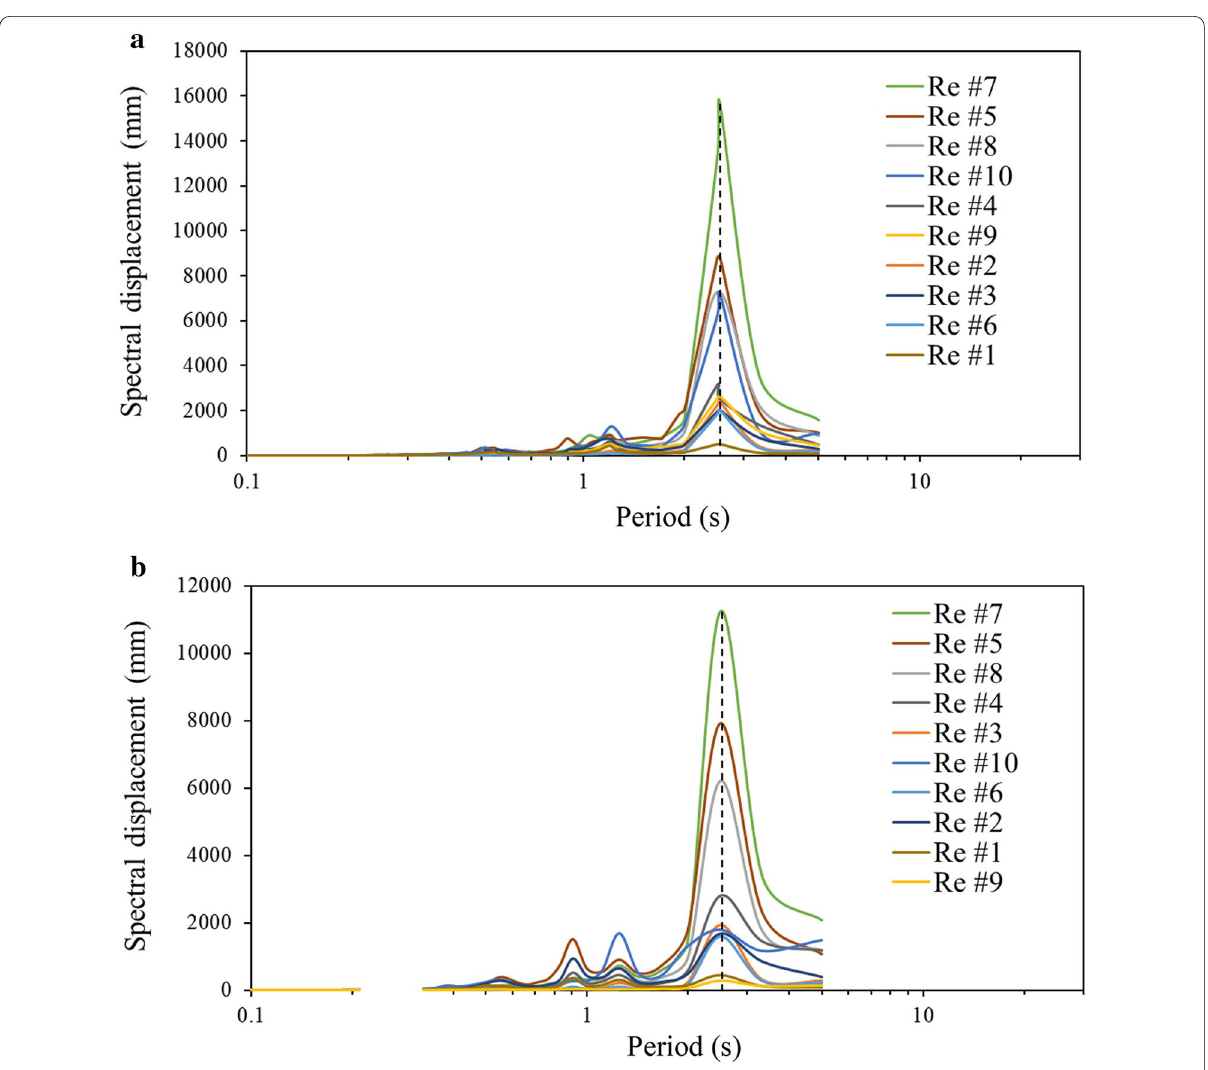
Fig. 9 Displacement response spectra: a velocity of 150 m/s, b velocity of 90